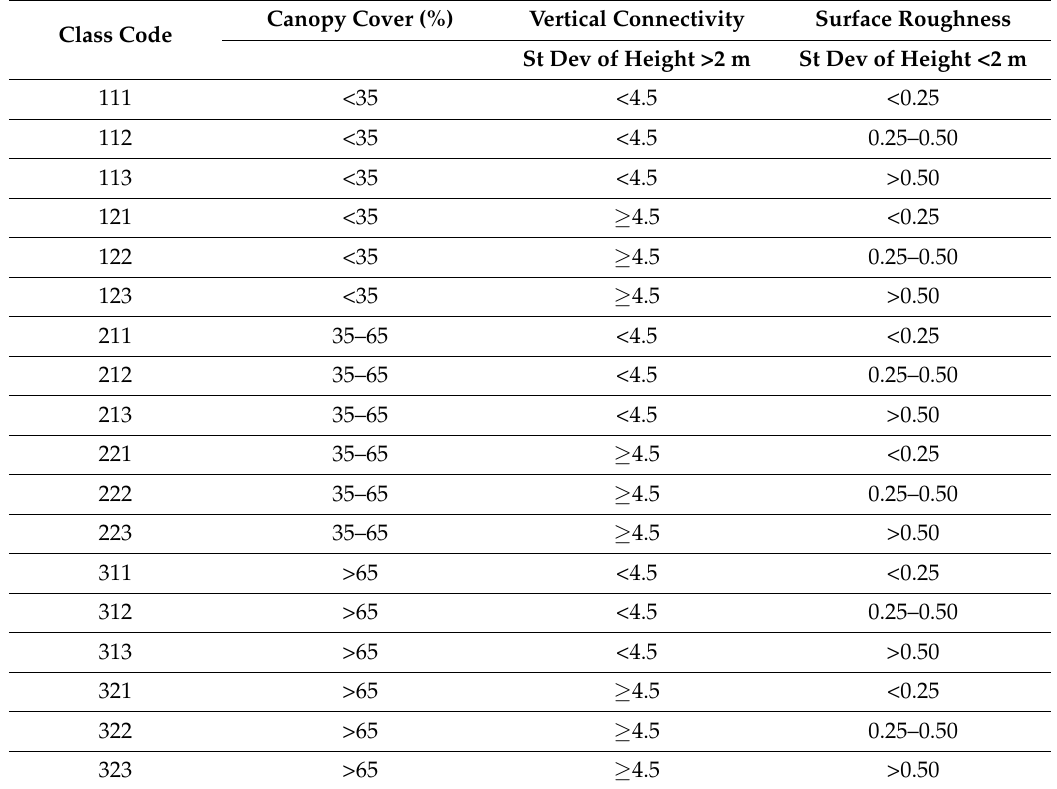
Table 1. Combinations of LAS derived structure metrics are used to create a forest structure